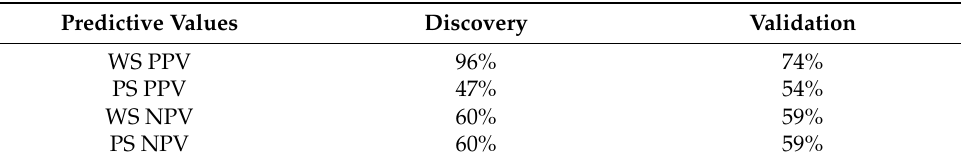
Table 2. Positive and negative predictive values of Wellness Score and PS in the discovery and validation cohorts at six